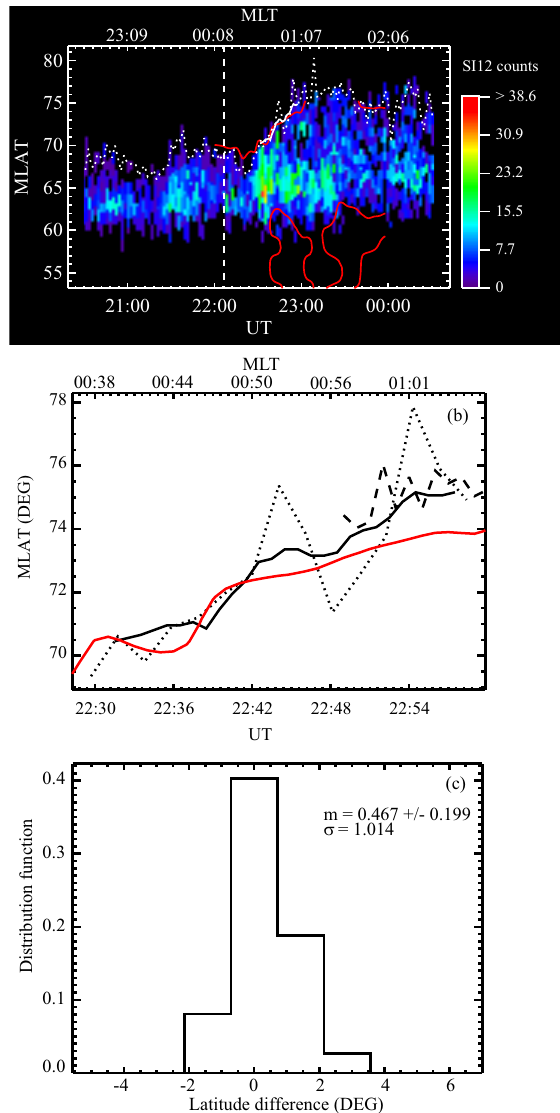
Fig. 4. Same as Fig. 2 for 17 February 2002, with, in addi- tion, the polar cap boundary deduced from observations of the OI 630nm emission at Longyearbyen represented by the dashed line in panel (b)